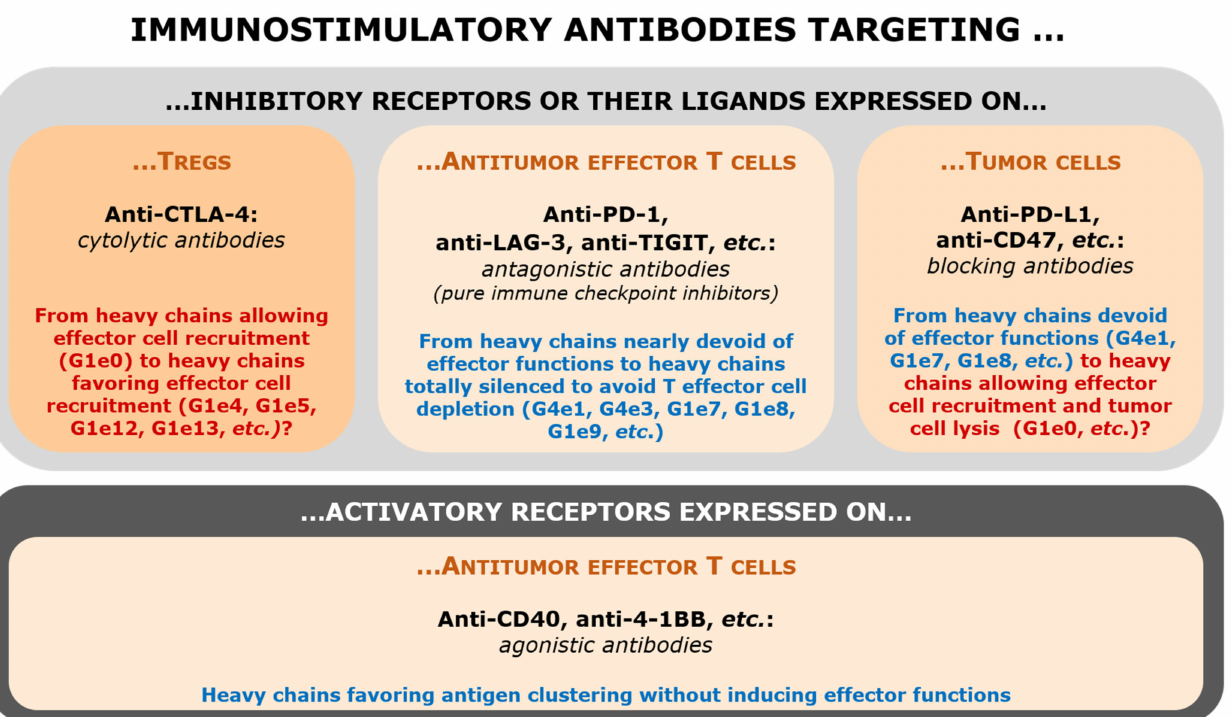
Figure 3. Immunostimulatory antibodies